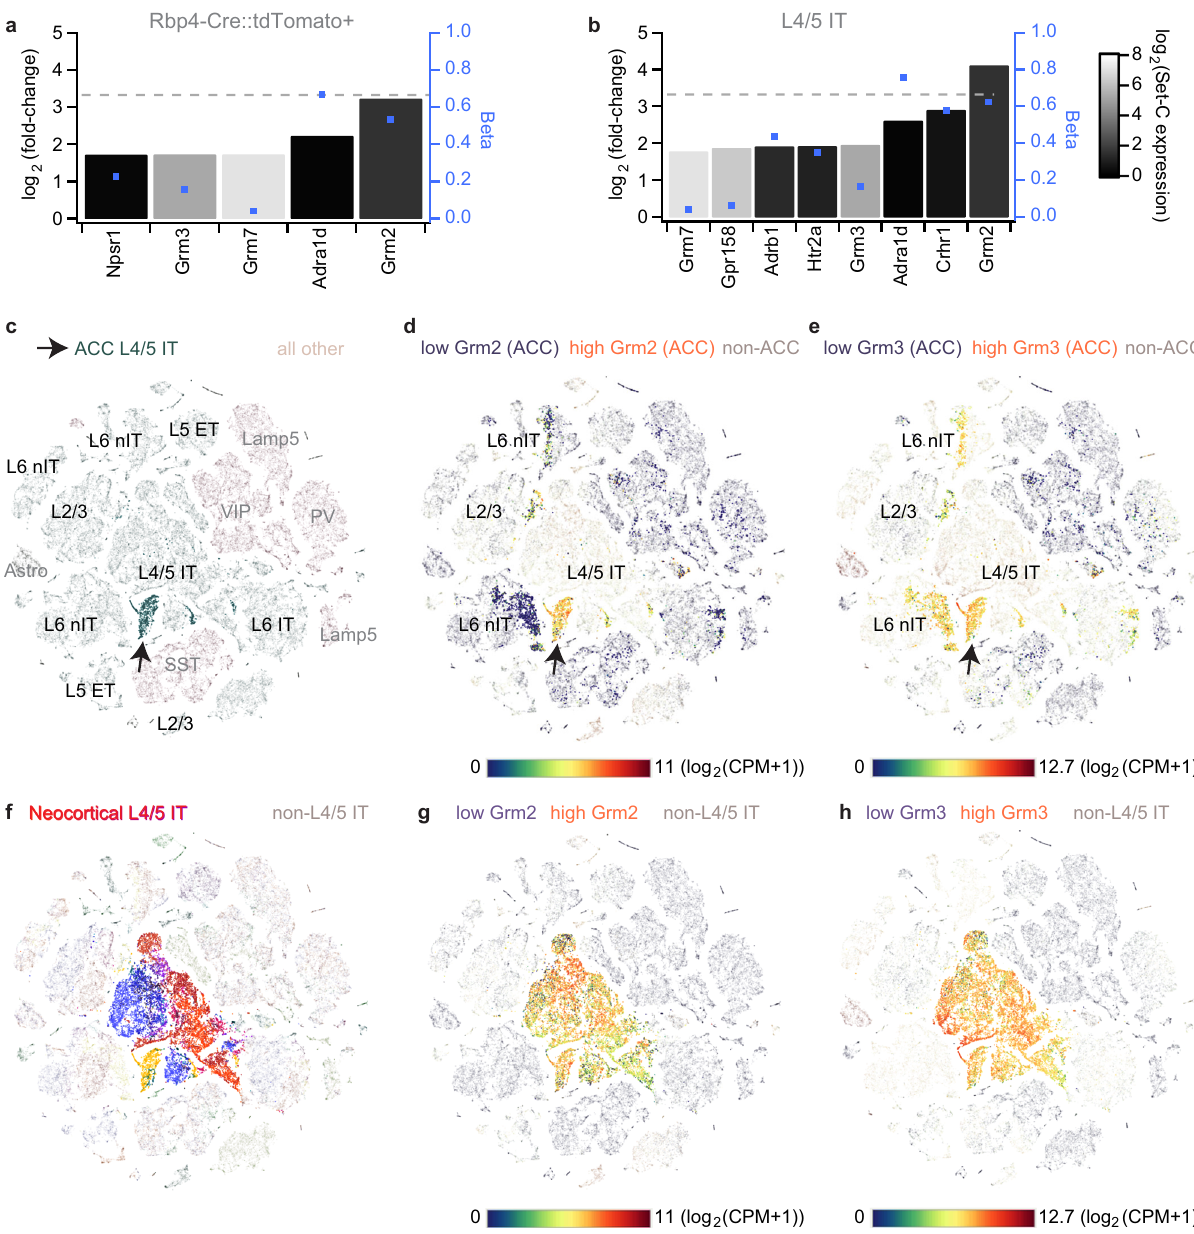
Fig. 5 Differential gene expression analysis across 402 GPCR-encoding genes within the mouse ACC. a, b Differential gene expression values (log 2 - transformed ratios of gene expression in target set of ACC L5-cells relative to a non-target set of GABAergic, L2/3/6 excitatory and non-neuronal ACC cells, N = 3514; left axis), difference of share of cells with expression in target set and non-target set (Beta, blue dots, right axis), and average expression level in non-target set (log 2 (CPM + 1); grey scale) are displayed for all GPCR-encoding genes that are among differentially expressed transcripts in target set (Bonferroni-corrected P < 0.05) and are expressed at least threefold higher in target set compared to the non-target set. Horizontal dotted line indicates a 10fold higher expression in the target set (referring to left axis). The calculation has been performed by either selecting tdTomato-positive excitatory cells extracted from an Rbp4-Cre::Ai14 line (i.e. using the same selection as for the chemogenetic experiments in Figs. 2 – 4; N = 676; a ), or by selecting clusters of L4/5 intertelencephalic-projecting (IT) cells according to the metadata ( N = 1238; b ). c t-SNE maps of cell-type clusters of the complete dataset 12 involving 20 cortical regions with the cells from the ACC target (green, arrow) sets indicated; overlaid black and grey names indicate clusters of excitatory and non-excitatory cells, respectively. d , e Expression levels — colour-coded according to the continuous scale below — of Grm2 (d) and Grm3 (e) projected onto the ACC cells of the t-SNE map shown in c indicate high expression of those genes majorly in excitatory cells, with Grm2 (compared to Grm3 ) showing a higher speci fi city for L4/5 IT cells. f Same plot as (c) but for displaying L4/5-IT cells across all analysed cortical areas (shown in different colours). Expression of Grm2 ( g ) and Grm3 ( h ) across L4/5 – IT cells of all analysed regions. Gene expression analysis and creation of t- SNE maps have been performed in CytosploreViewer. See Supplementary Data 2 for details of sets, results and analysed GPCR genes, and Supplementary Fig. 3 for the same analyses as in a , b ) using a reduced number of cell types for the non-target